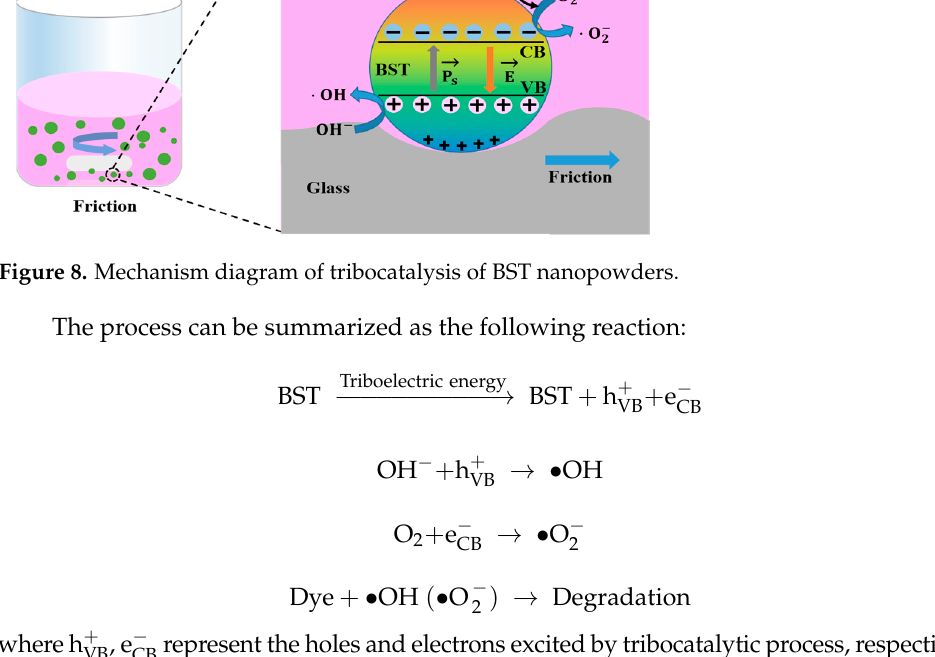
magnetic stirring setup; Figure S2: Raman spectra of BTO nanopowders; Figure S3: EDS patterns of Ba 1 − x Sr x TiO 3 nanopowders when x is: (a) x = 0; (b) x = 0.1; (c) x = 0.2; (d) x = 0.3; Figure S4: Adsorption efficiency of BST nanopowders on RhB solution within 30 min; Figure S5: XRD patterns of BST-0.2 nanopowders before and after three cycles; Figure S6: UV-Vis absorption spectrum